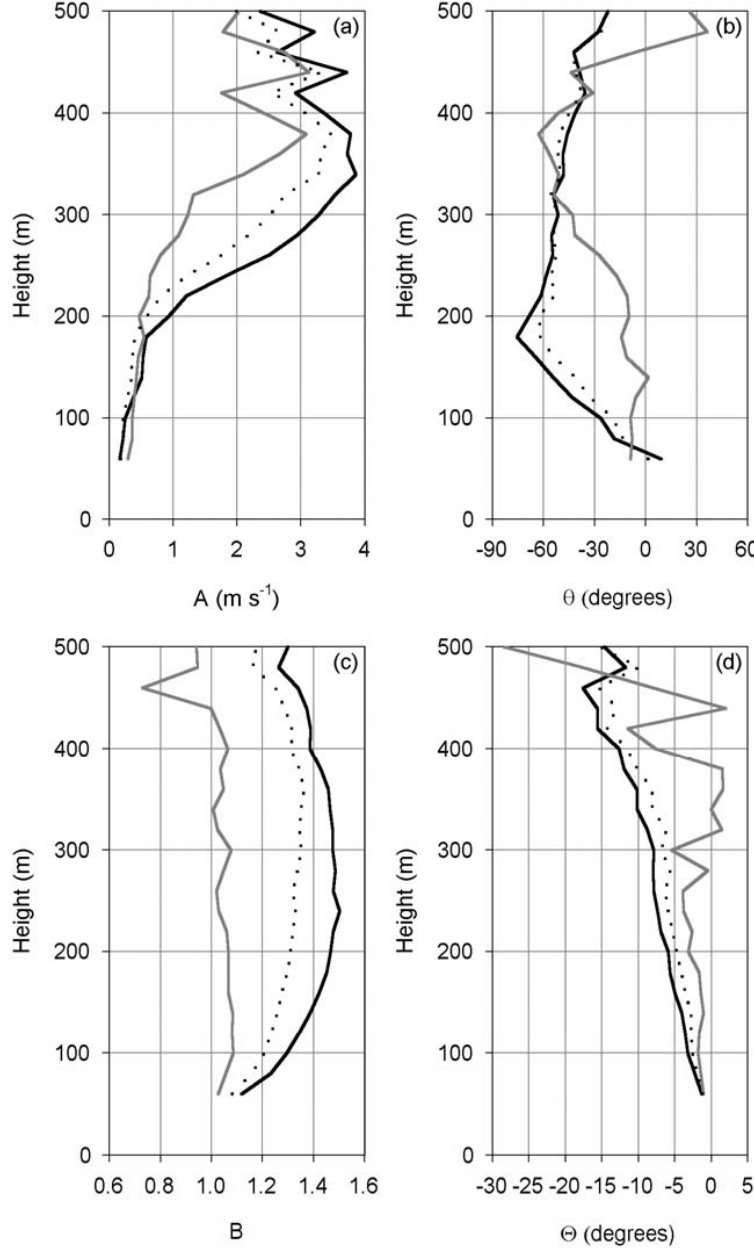
Fig. 10. Change with height for different parameters corresponding to vector correlation, dotted line for the global data, in black for the night and in grey for the